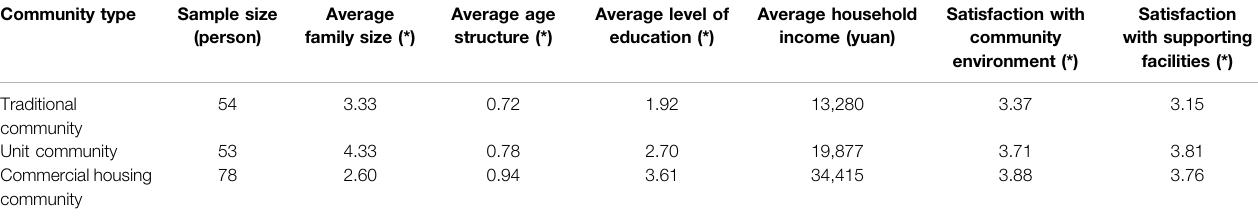
TABLE 5 | Basic characteristics of three typical communities. Community